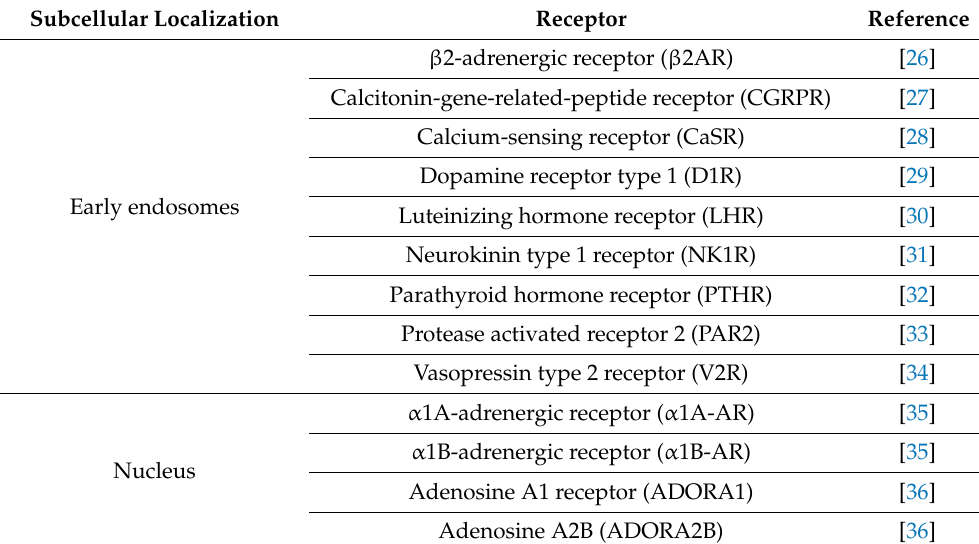
Figure 1. GPCRs ’ main cell localization. GPCRs are represented as orange proteins with carboxyl groups shown as gray dots and N-terminal groups with symbols of different colors, blue, green, red. Canonically functional GPCRs localize at the plasma membrane level (“1”), but they can also be functional on the membrane of different intracellular compartments: endosomes where their carboxyl domains face the cytosol (“2”); the Golgi apparatus, where they constitute a pre-existing receptor pool and to where they are delivered after being assembled in the perinuclear endoplasmic reticulum (“3”, “4”, respectively); the nucleolus, on the outer and inner nuclear membrane where the GPCR carboxyl domains face the cytosol or the nucleoplasm, respectively (“5”, “6”). GPCRs can also form pre-existing pools in the nuclear inner membrane with their carboxyl domain facing the nucleoplasm (“7”). Finally, GPCRs can be found in the mitochondrial outer membrane where their GPCR carboxyl domains face the intermembrane space (“8”). Table 1. List of GPCRs that signal from intracellular compartments.